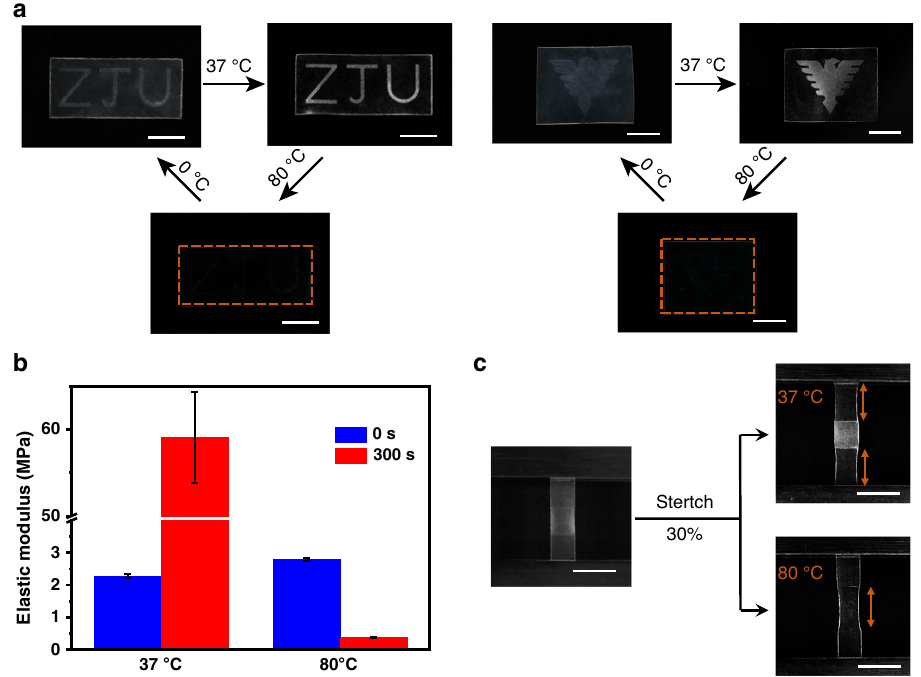
Fig. 3 Spatio-selective topological isomerization. a Temperature induced change in optical contrast due to the patterned isomerization/crystallization. The letters and logo correspond to the isomerized region with light irradiation of 300 s. The rest of the sample corresponds to non-isomerized region with no light irradiation. b Comparison of the elastic moduli for the non-isomerized and the isomerized network. c Reversal of modulus contrast at different temperatures. All scale bars: 10 mm and error bars represent standard deviations calculated from three